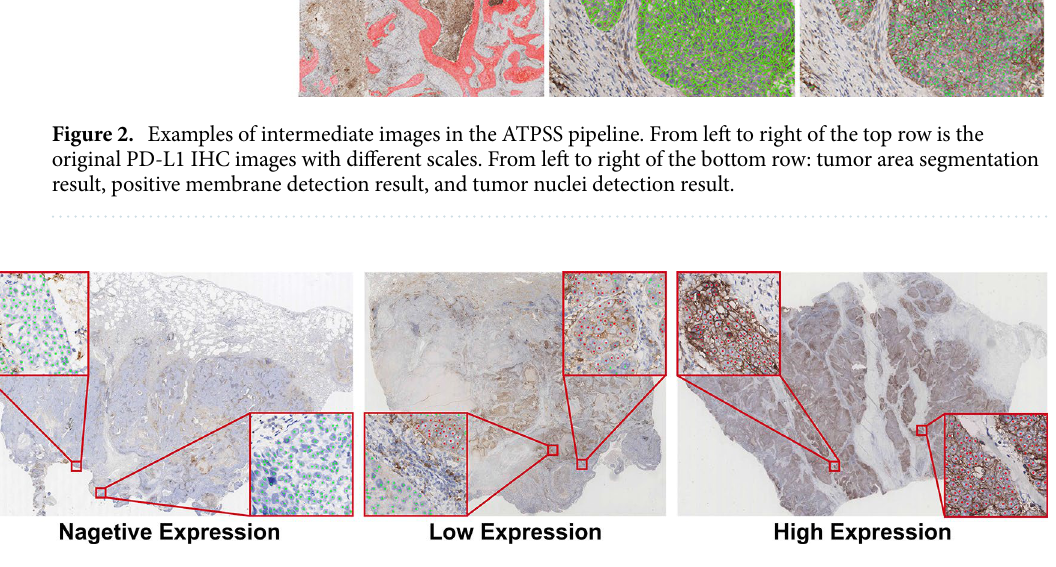
Figure 3. Examples of comprehensive results of proposed ATPSS that combine three intermediate results. The slides show different PD-L1 expression levels. Red dots indicate positive PD-L1 stained tumor cells, while green dots depict tumor cells negative for PD-L1